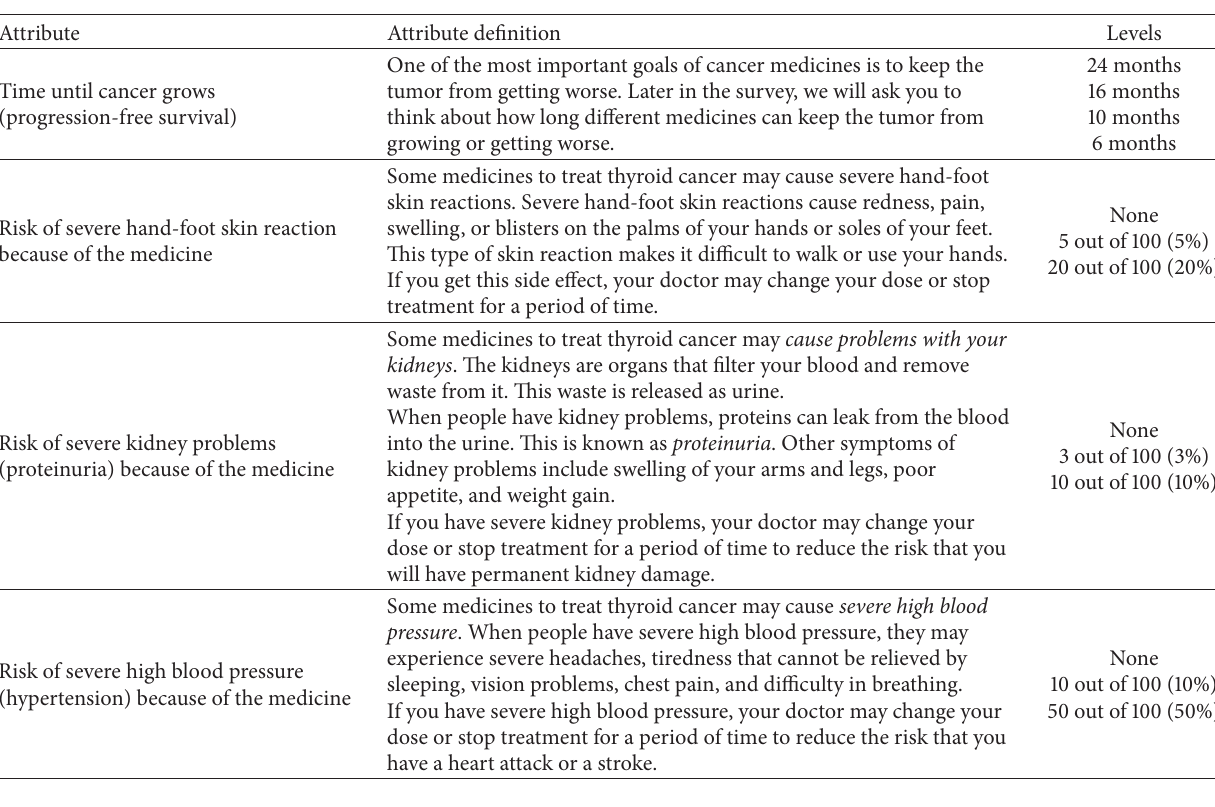
Table 1: Attributes and levels included in the final survey instrument.